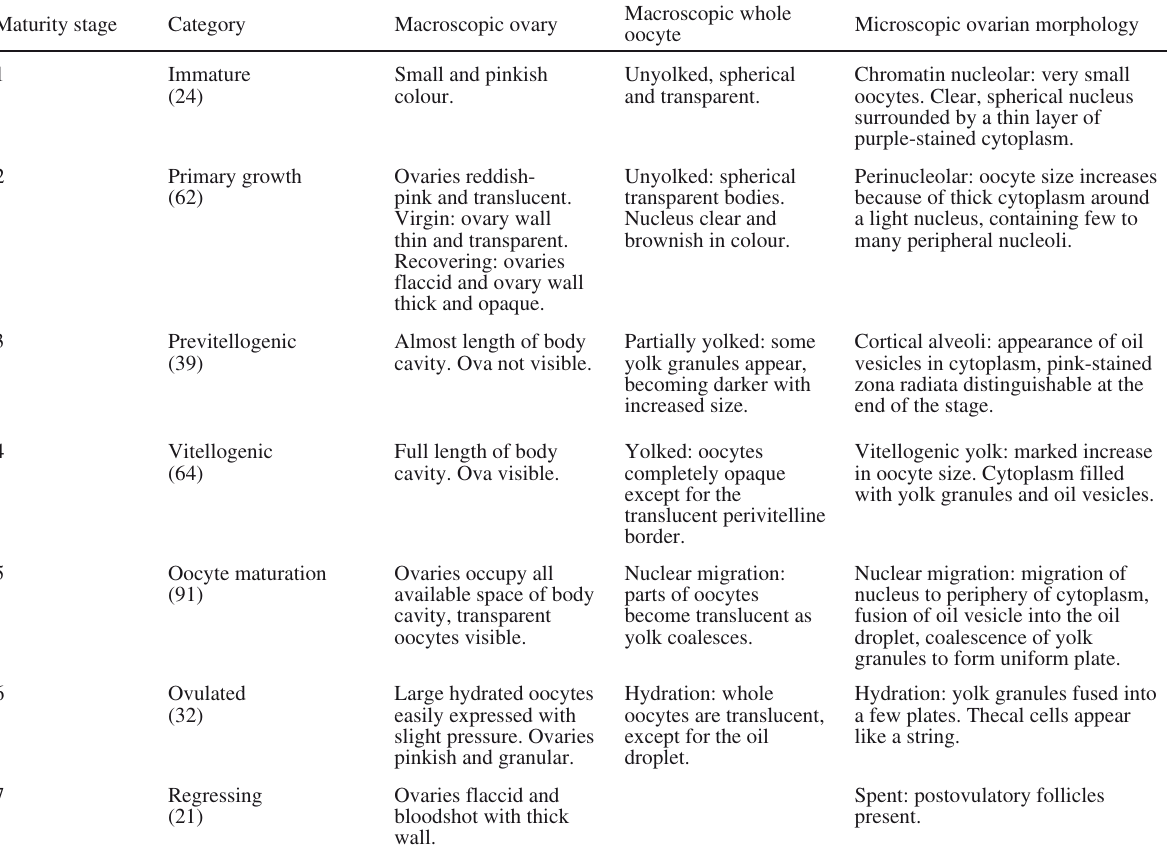
Table 1. – Microscopic, macroscopic, and histological staging criteria used for common kilka ovaries (Lowerre-Barbieri et al . 2011a, Brown- Peterson et al . 2011). Numbers in parenthesis are the number of kilka in each maturity